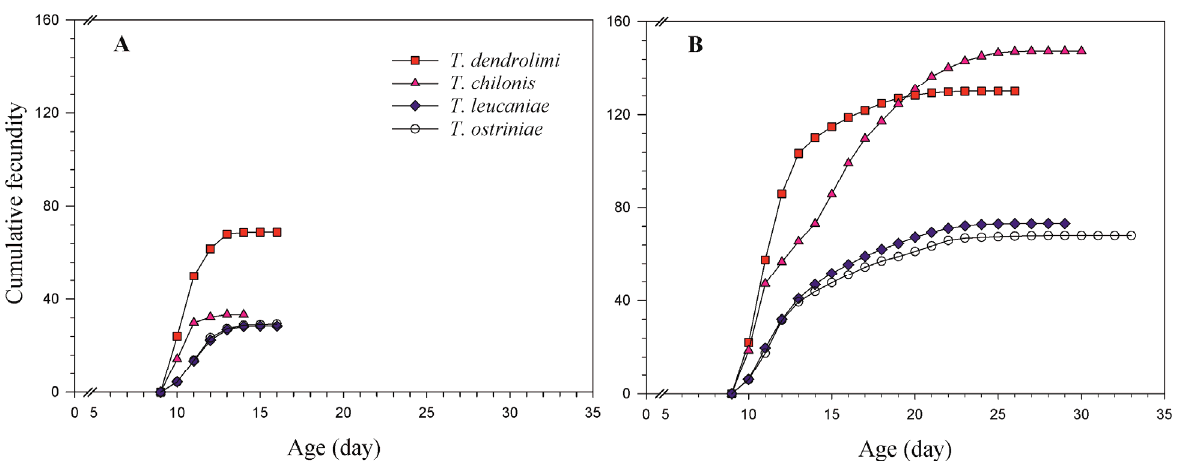
Figure 4. Cumulative fecundity of four Trichogramma species parasitizing C. cephalonica eggs. Fed with water ( A ) and fed with honey ( B ).